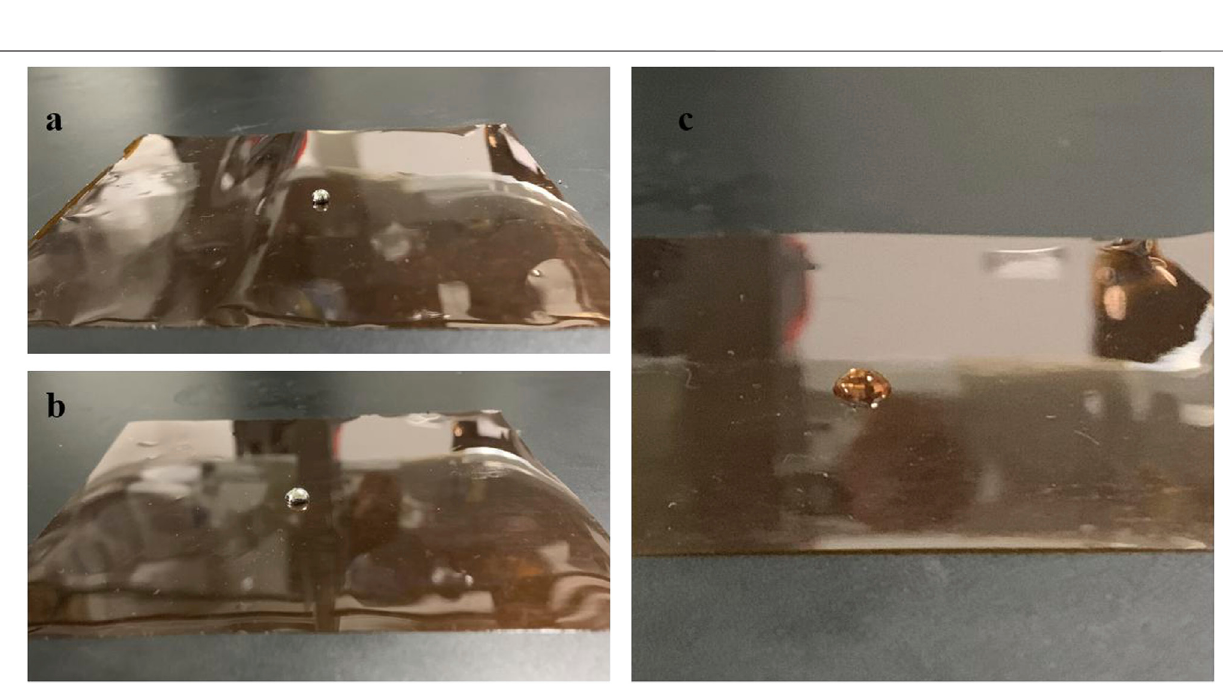
Frontiers in Materials |